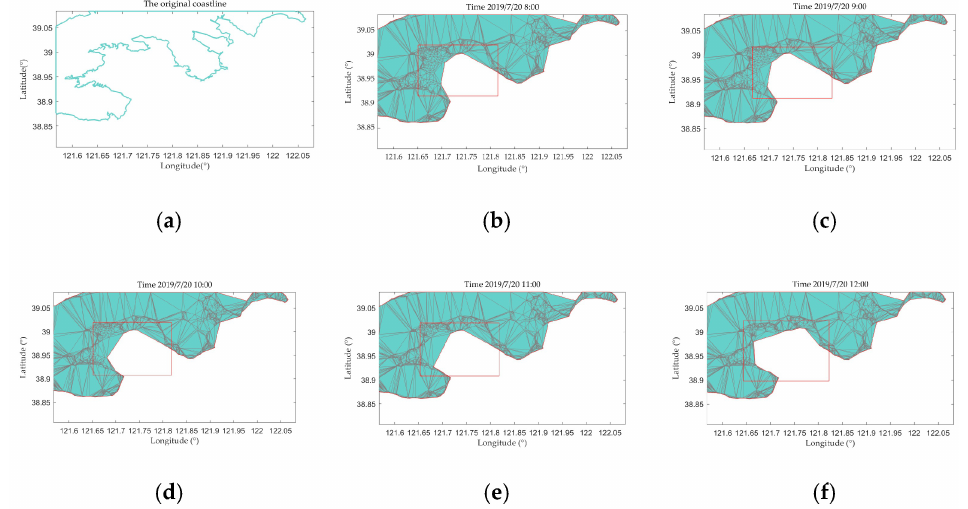
Figure 7. Hourly safe water depth environment model: ( a ) represents the initial coastline; ( b – f ) represent a safe water depth environment model for five hours.